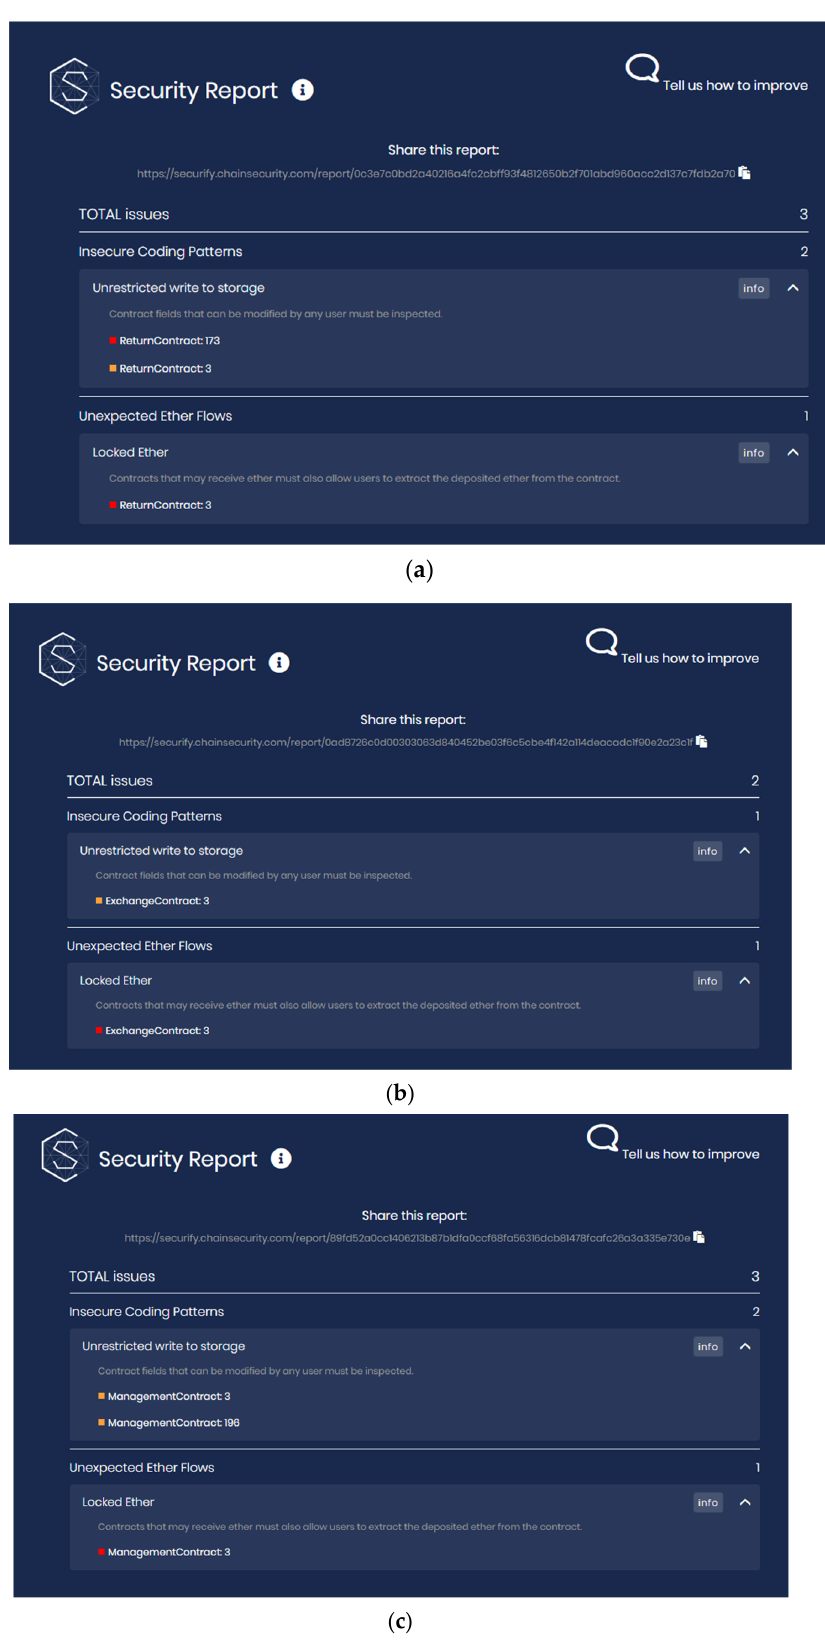
Figure 8. ( a ) Security analysis report for the Return contract. ( b ) Security analysis report for the